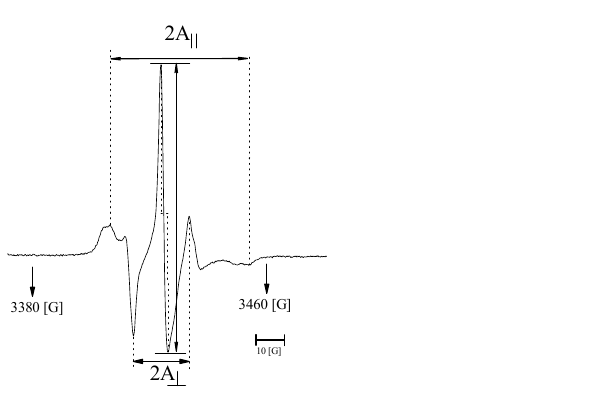
Figure 2. Typical EPR spectrum of spin marker 5-DOXYL located in the liposome membrane. The parameter a (cid:48) N Equation (3) obtained on the basis of the spectra allows us to determine the polarity of liposomal membranes and their fluidity, depending on the polarity of surroundings during liposome preparation. The increase in the value of the a (cid:48) N parameter indicates an increase in the polarity of the membrane